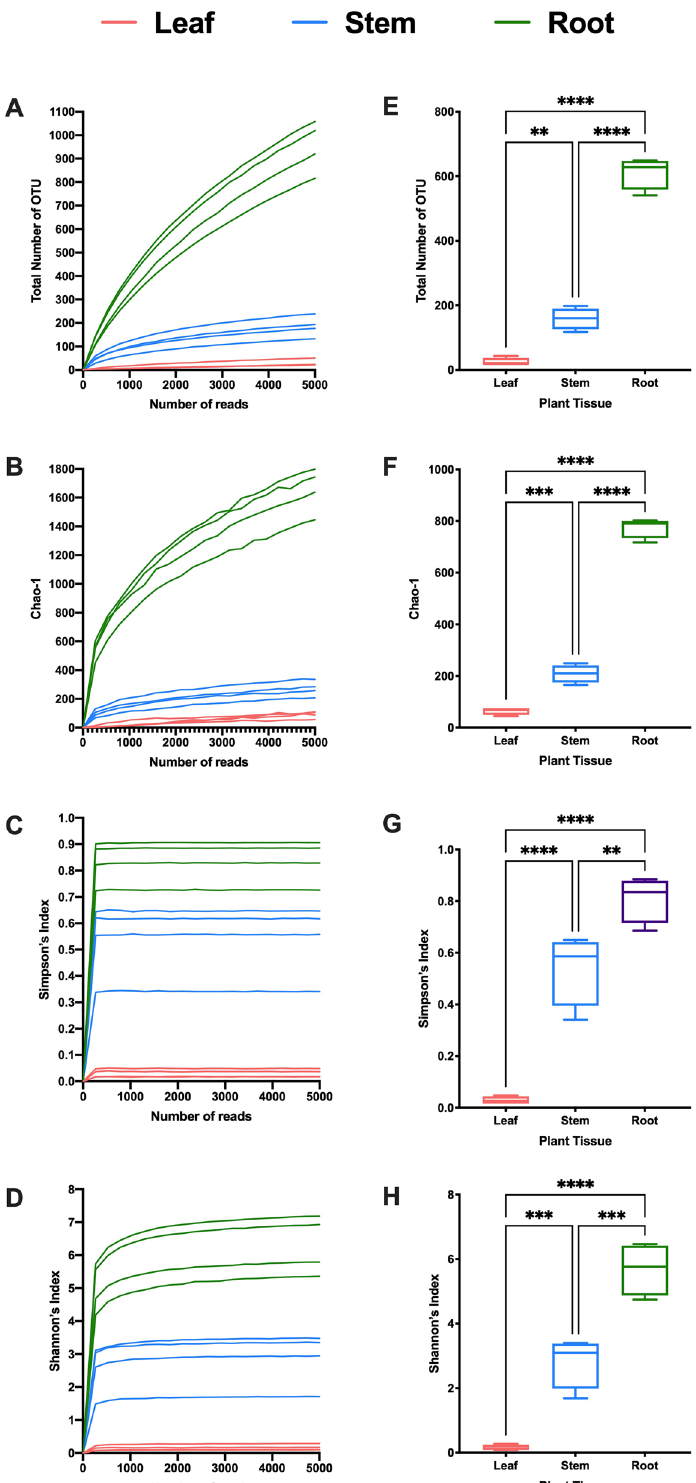
Figure 1. Alpha diversity in Ginkgo biloba tissues. ( A – D ) Rarefaction curves indicating sufficient depth of sequencing based on ( A ) Total number of operational taxonomic units (OUT), ( B ) Chao-1 index, ( C ) Simpson’s index, and ( D ) Shannon’s index. ( E – H ) Alpha diversity in Ginkgo biloba tissues based on ( E ) Total number of OTU, ( F ) Chao-1 index, ( G ) Simpson’s index, and ( H ) Shannon’s